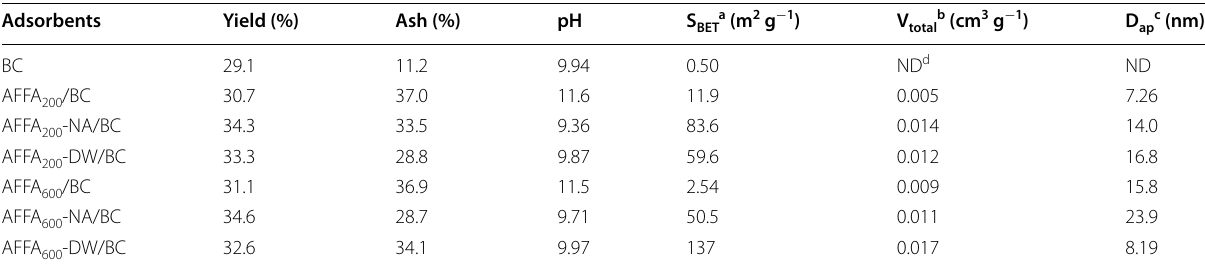
Table 1 Basic characteristics of BC and AFFA/BC